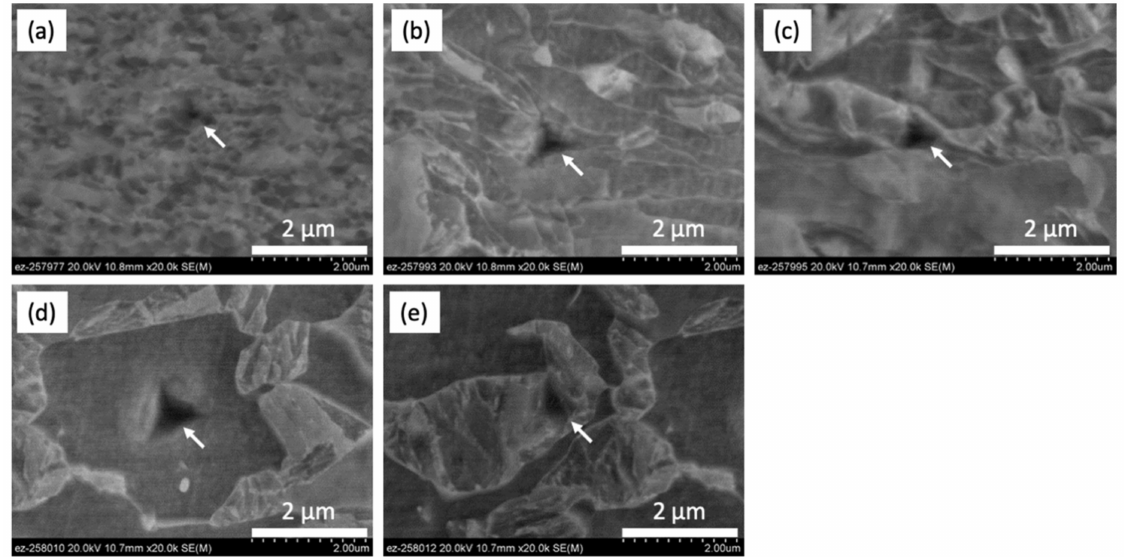
Figure 16. Representative SEM images of nano-indentation on each microstructure for sample A: ( a ) FG area; ( b ) ferrite; ( c ) martensite at the DG area; ( d ) ferrite; and ( e ) martensite at the BM. White arrow points indented location at each